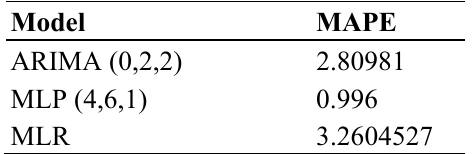
Table 5. The comparison of errors from the three methods.